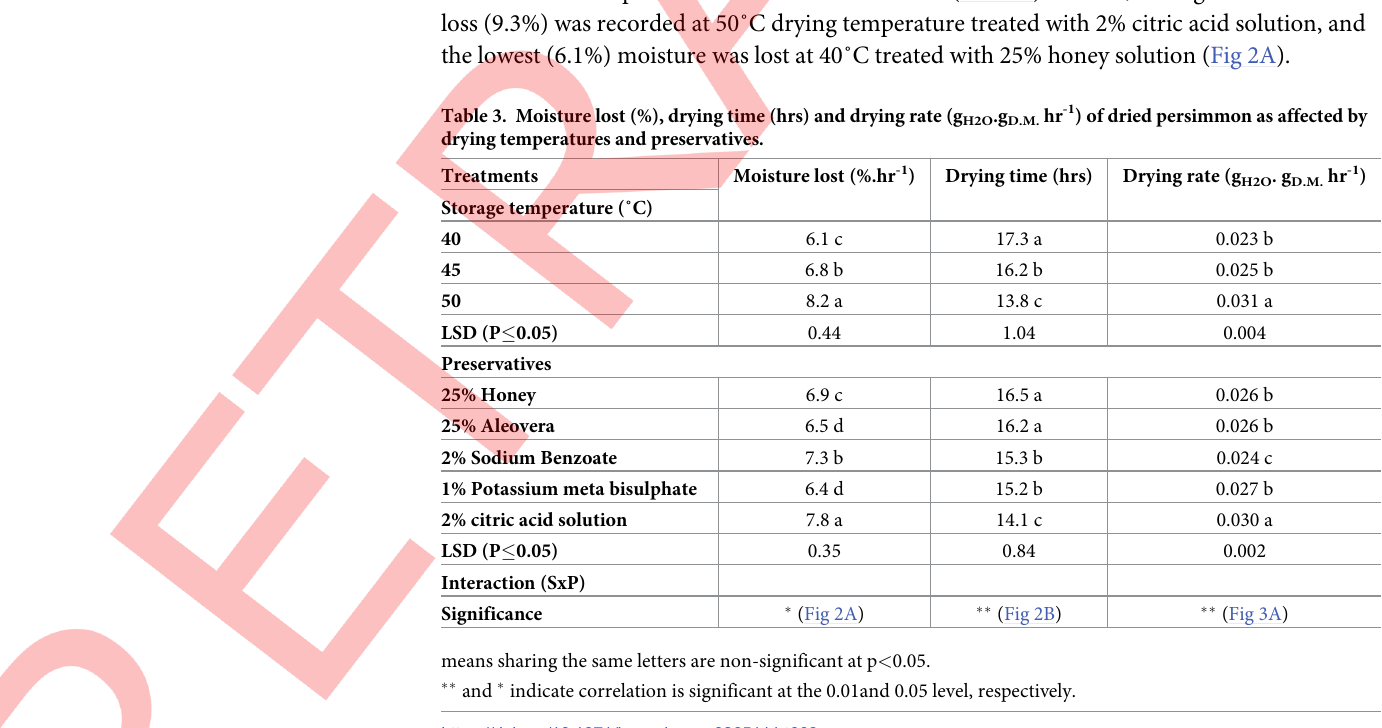
means sharing the same letters are non-significant at p < 0.05. �� and � indicate correlation is significant at the 0.01and 0.05 level,